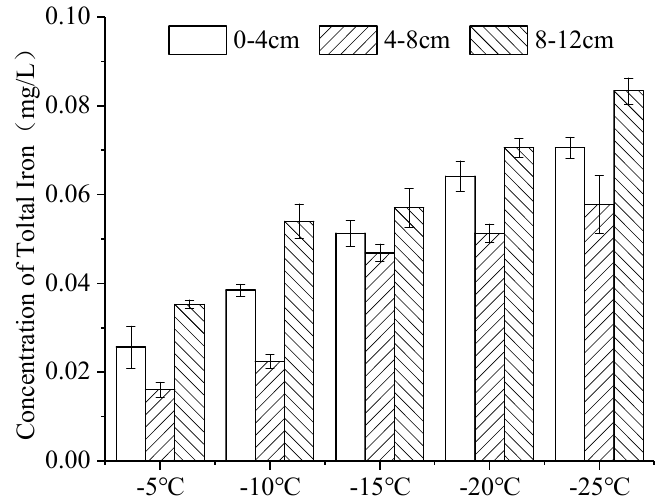
Figure 7. Distribution of iron at varying freezing temperatures in the ice body. (Error bar: Mean ± S.D., K: the ratio of the average concentration of iron in the ice to that in the under ‐ ice water).